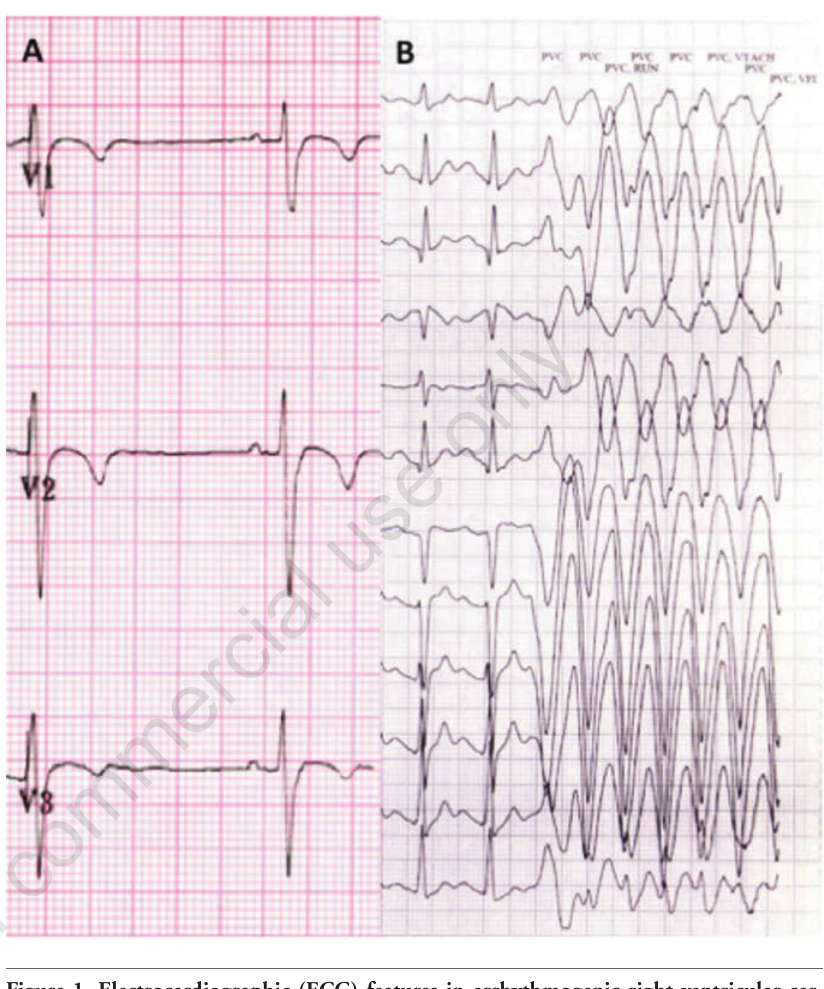
1. Electrocardiographic (ECG) features in arrhythmogenic right ventricular car- diomyopathy (ARVC). Panel (A) demonstrates T wave inversion in the right precordial ECG leads V -V . Panel (B) demonstrates onset of left bundle branch block ventricular 1 3 tachycardia with superior axis during